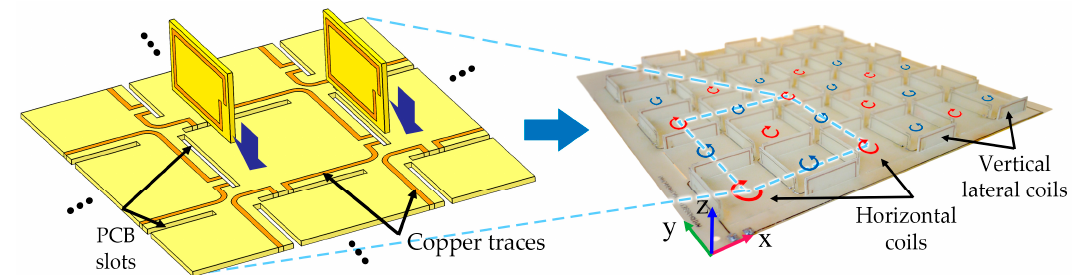
Figure 5. The vertical coils were slotted into the horizontal printed circuit board (PCB) openings. All the loops were serially connected. The connections were fixed by soldering and gluing.